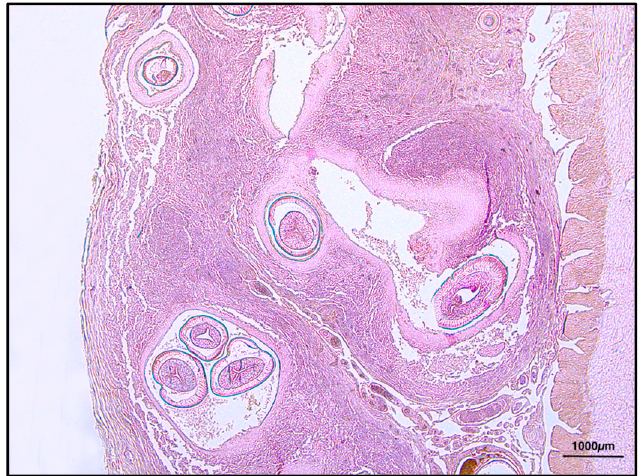
Figure 3. Mucosal granulomatous reaction with nematodes inside, H&E 2.5×. Up to five different stages of granuloma were detected (i.e., containing free larvae, encysted parasite, early, intermediate, mature (Figure 4a–d); some granulomas without parasites inside were also found (Figure